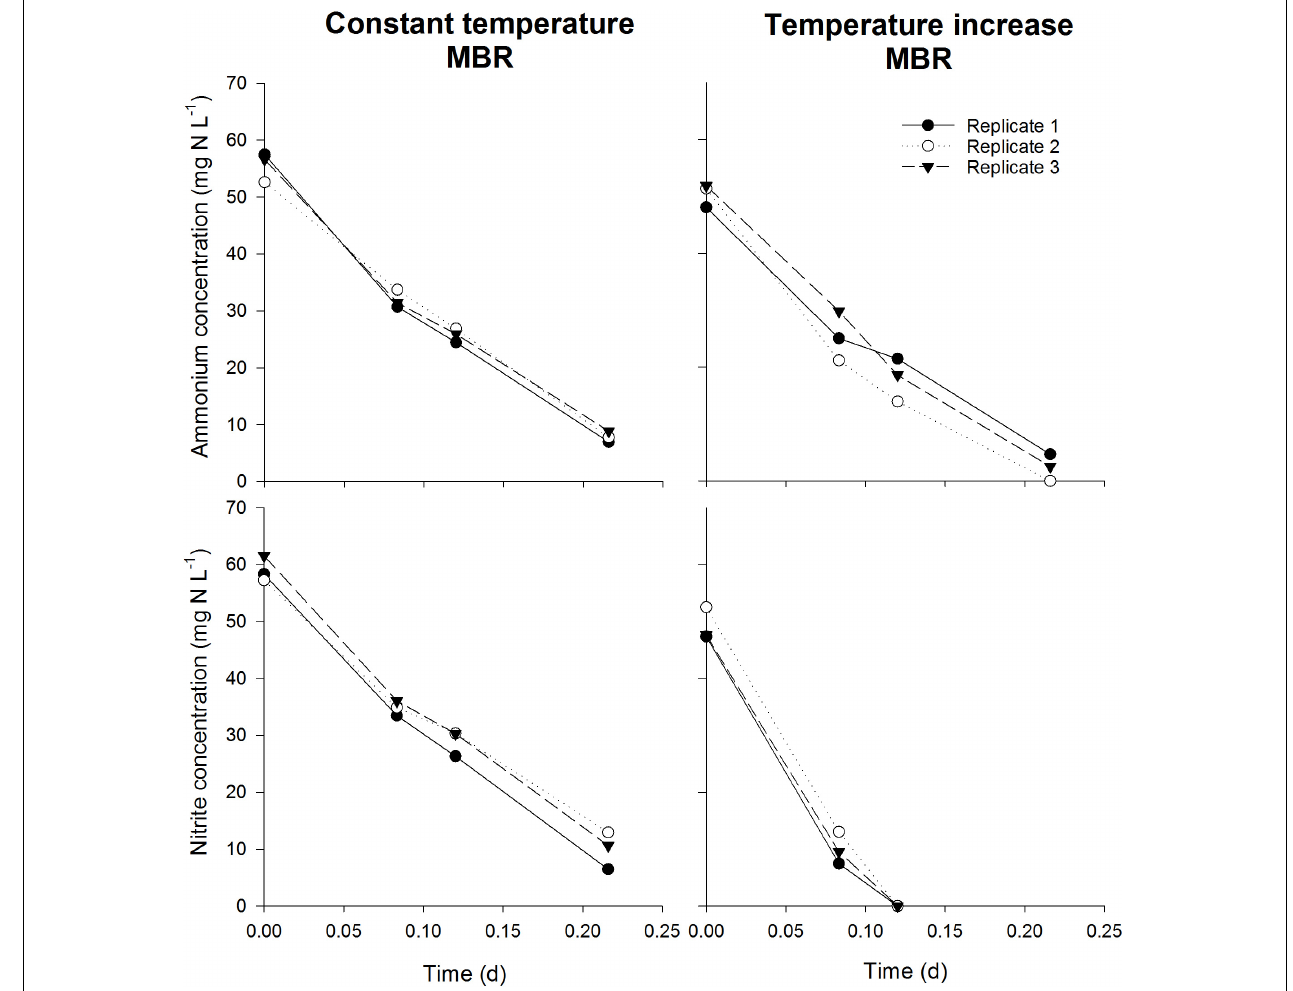
FIGURE 7 | Ammonium (top) and nitrite (bottom) concentrations in the closed serum flasks ( n = 3) during the activity measurements of the validation experiment. The linear decrease of concentration depicts the optimal conditions and non-limiting oxygen concentration. Too few measurements were available for reliable NOB rate determination in the “temperature increase MBR” incubation. However, the aim of this experiment was to determine possible oxygen limitation, which is